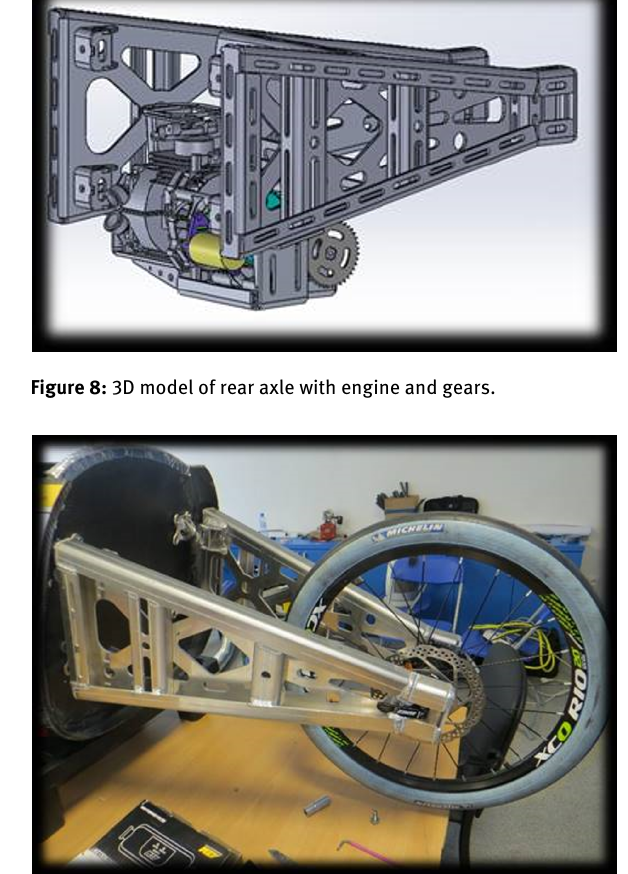
Figure 9: Rear axle without other accessories.